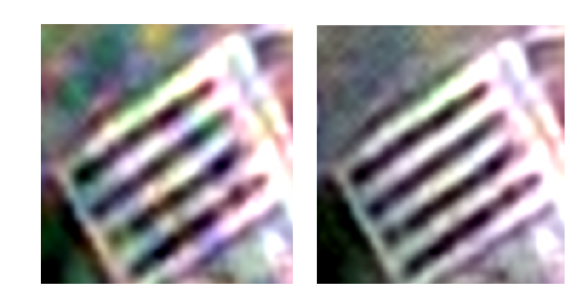
Figure 5. Pan-sharpening of a Pl´eiades image. Zoom over a road crossing restored without ( Left ) and with ( Right ) prior noise res- toration. Adapted from Figure 6 from Delvit et al.